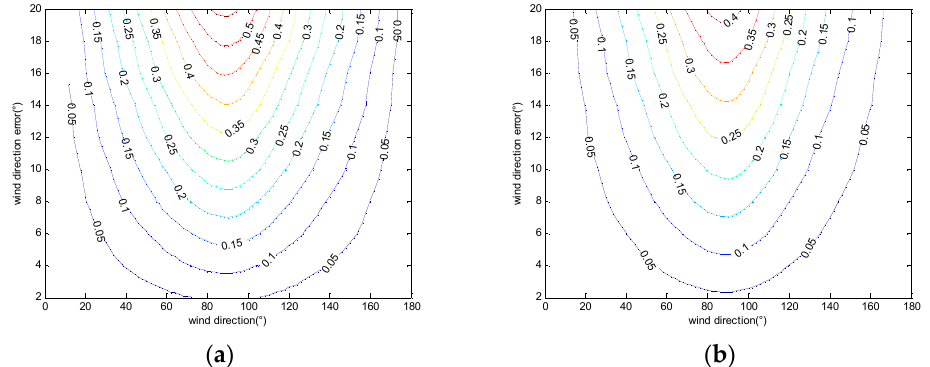
Figure 6. Surface current velocity errors due to different wind direction errors: ( a ) HH polarization; ( b ) VV polarization.